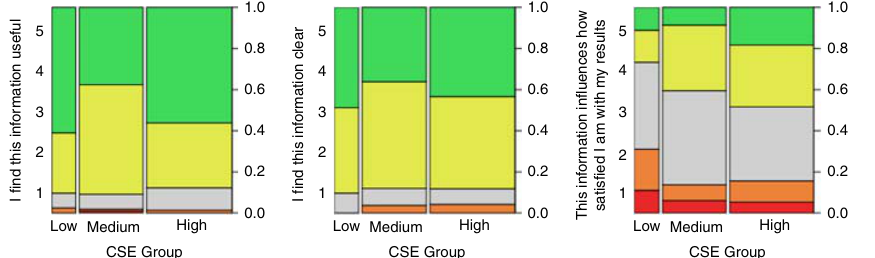
Figure 6. Marimekko charts encoding the responses to the